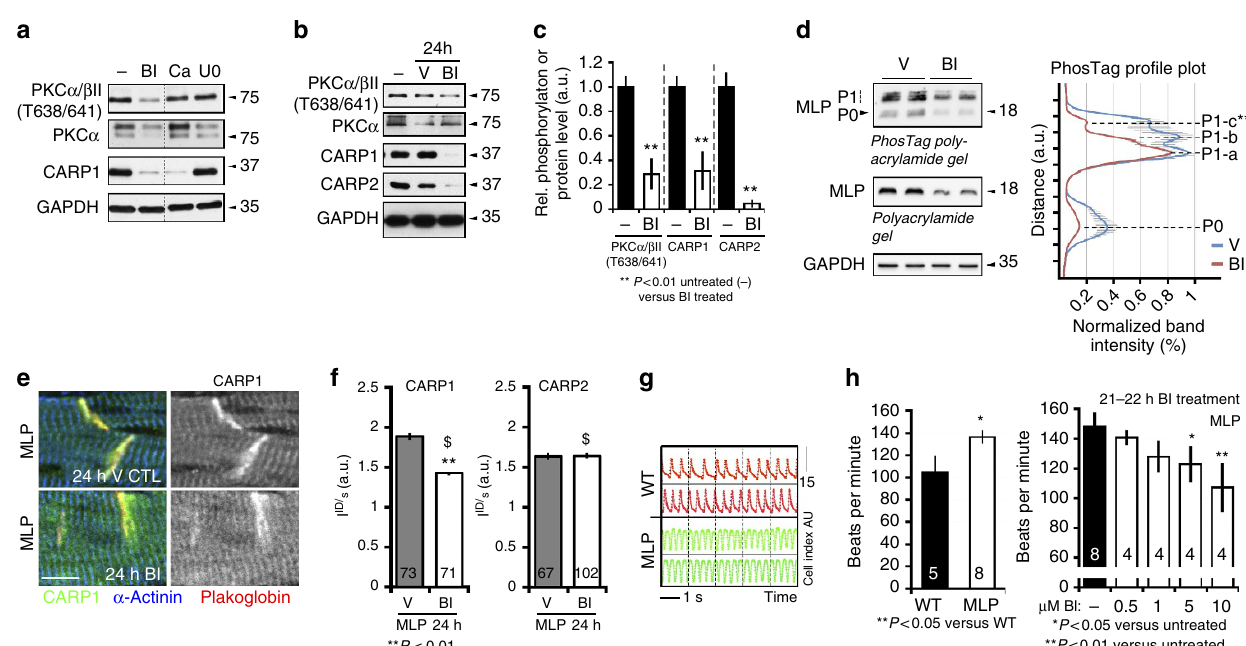
Figure 3 | Inhibition of PKC a affects CARP1 expression and localization and decreases MLP phosphorylation. ( a ) Effect of PKC inhibitors (10 m M